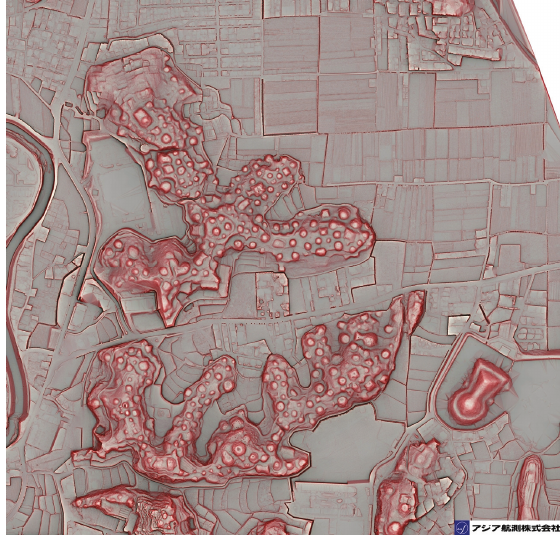
Fig11. Nizawa-senduka (RRIM of Lidar data)